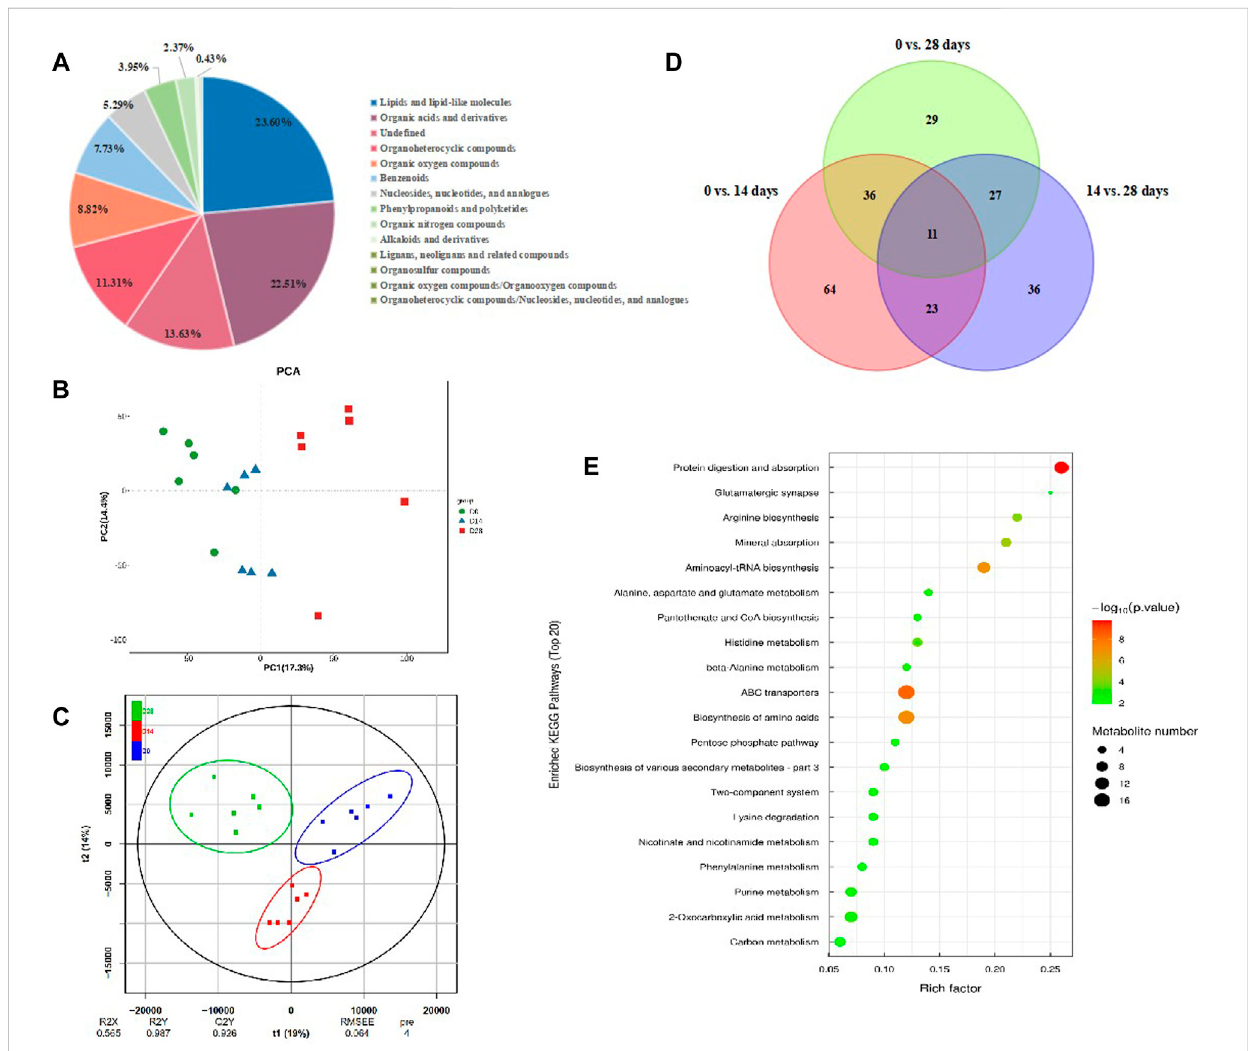
FIGURE 8 Intestinal metabolites change in C. bilineata tsingtauica during the diapause period. (A) The proportion of identi fi ed intestinal metabolites in each chemical classi fi cation. PCA (B) and OPLS-DA (C) ananlysis on intestinal metbolites among different treatments; (D) The number of intestinal differential metabolites in diapause larvae. (E) KEGG enrichment analysis on differential metabolites in diapause